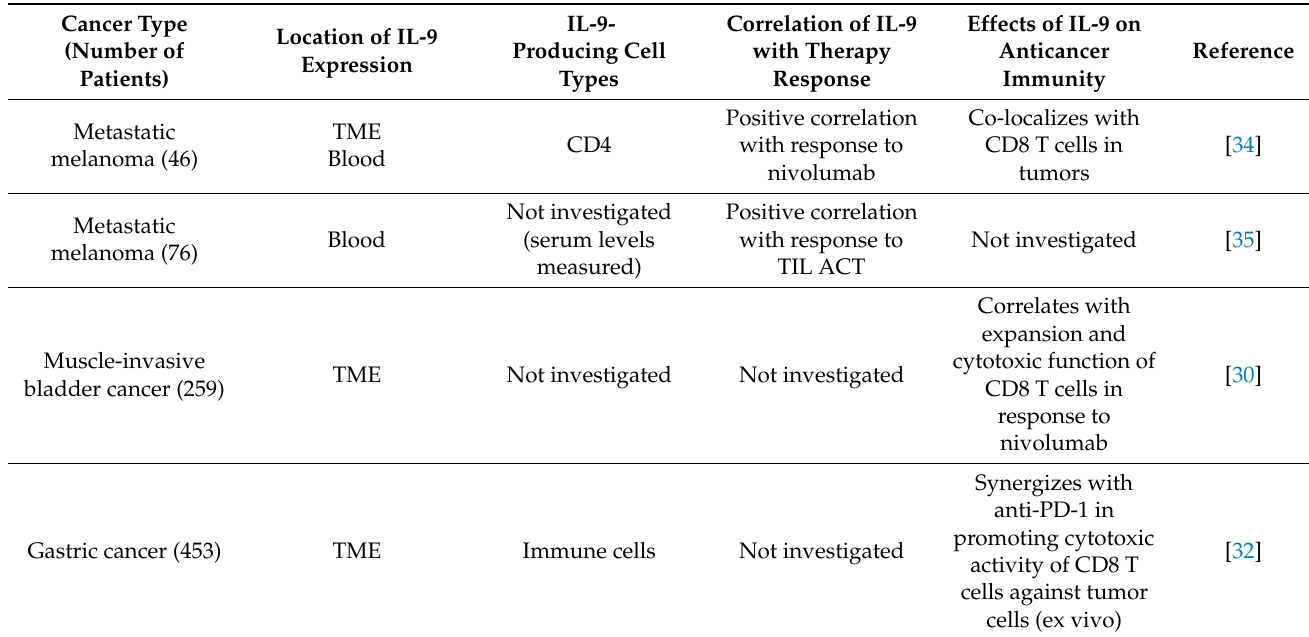
Table 2. The role of IL-9 in the response to cancer